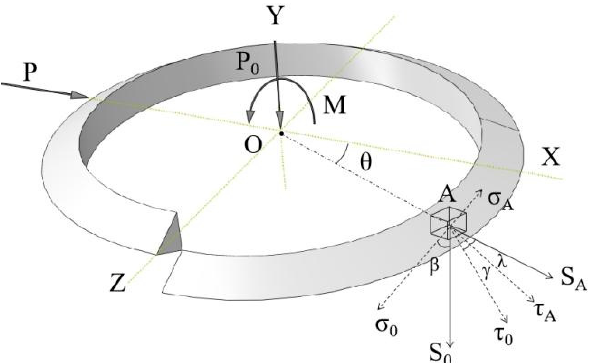
Figure 3. Speci fi c force diagram of thread surface of bolt under transverse vibration load. Figure 3. Specific force diagram of thread surface of bolt under transverse vibration